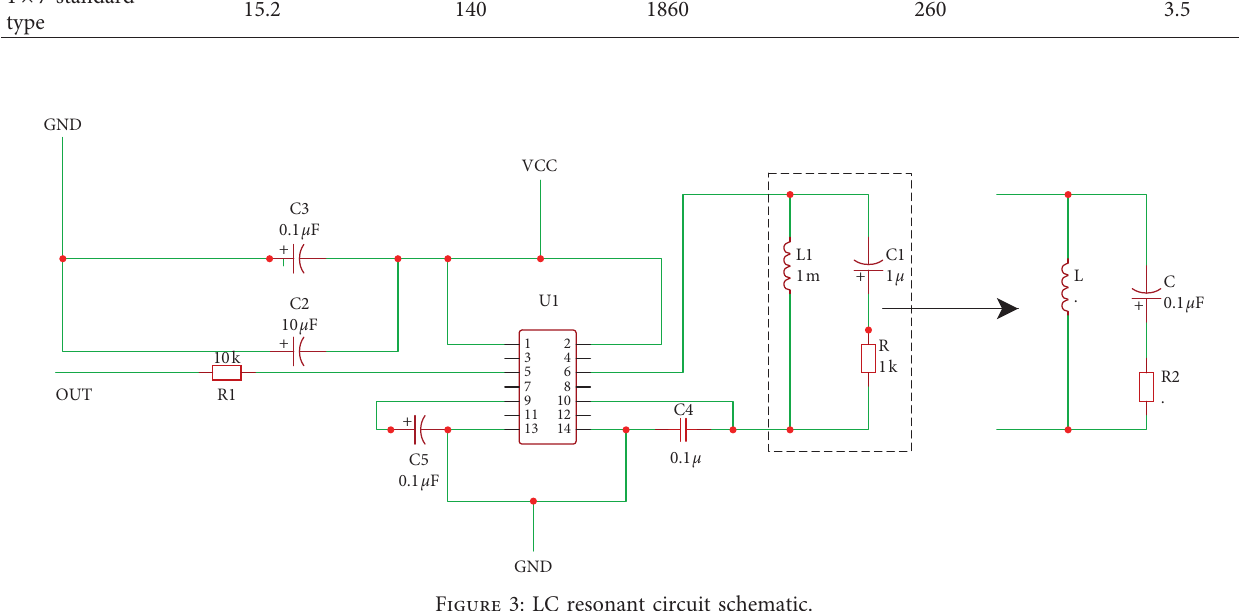
Figure 3: LC resonant circuit schematic.